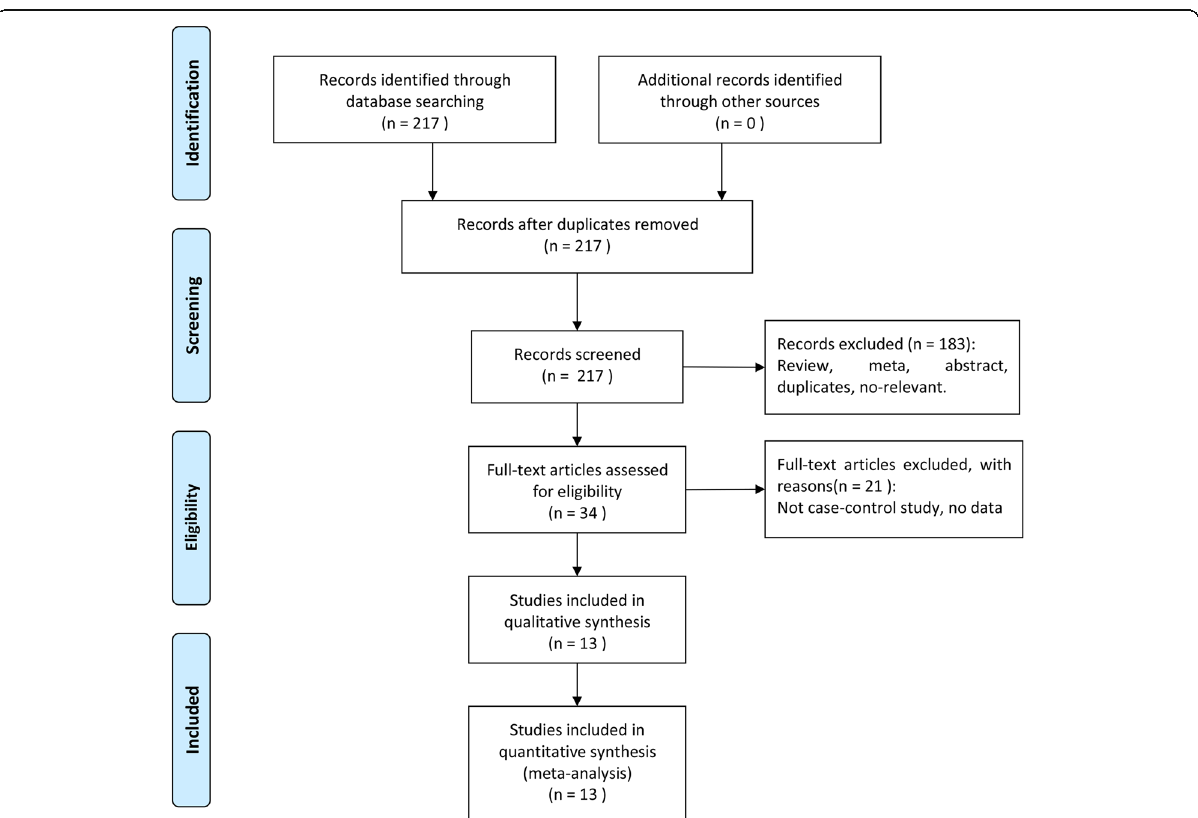
Fig. 1 Flow chart of the literature retrieval and selection